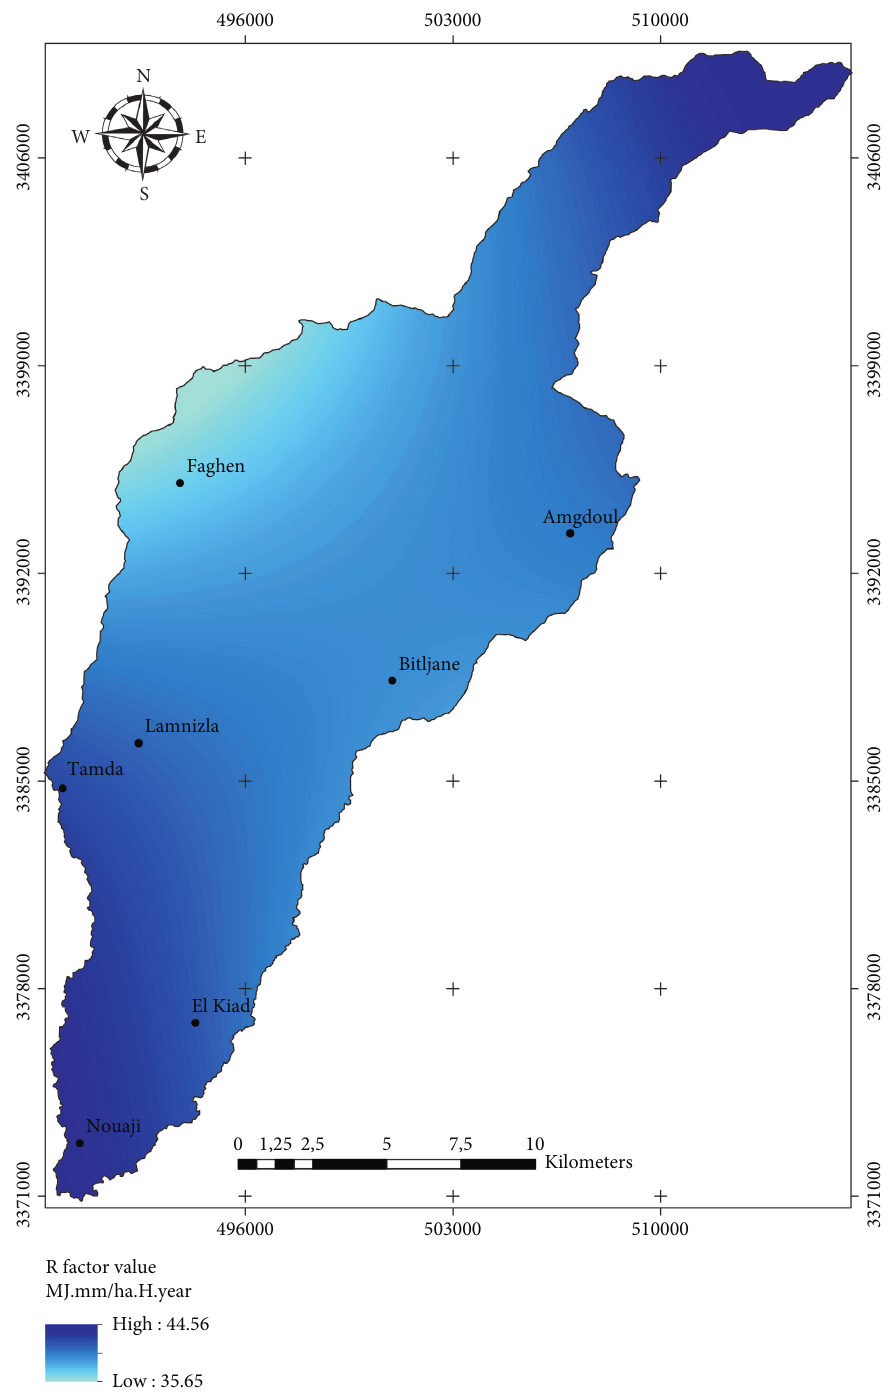
Figure 4: Spatial distribution of rainfall erosivity factor ( R ) at Beni Mohand River